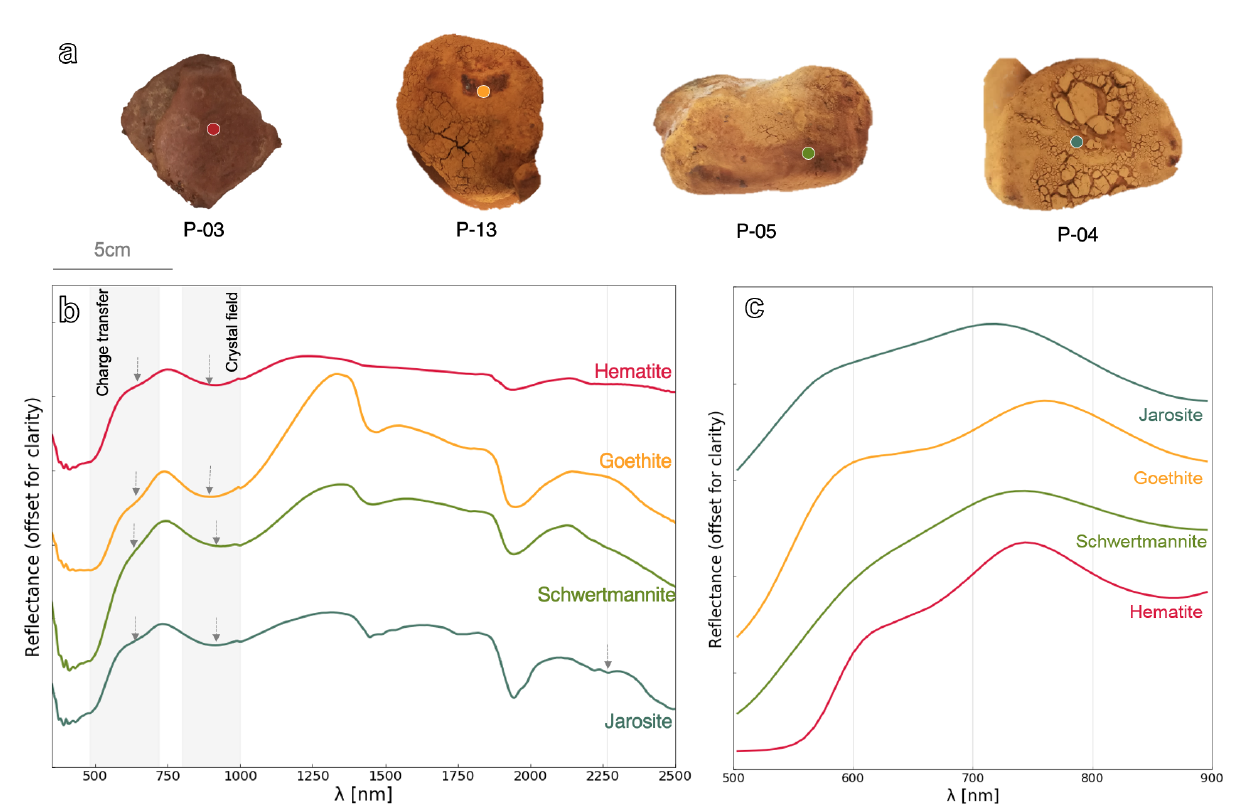
Figure 7. ( a ) Field samples, indicating the point-spectral measurements. ( b ) Spectral curves for the main minerals found in the region (hematite, goethite, jarosite, and schwertmannite), indicating prominent absorption features of each. ( c ) Reference spectra resampled to Rikola spectral range (504–900